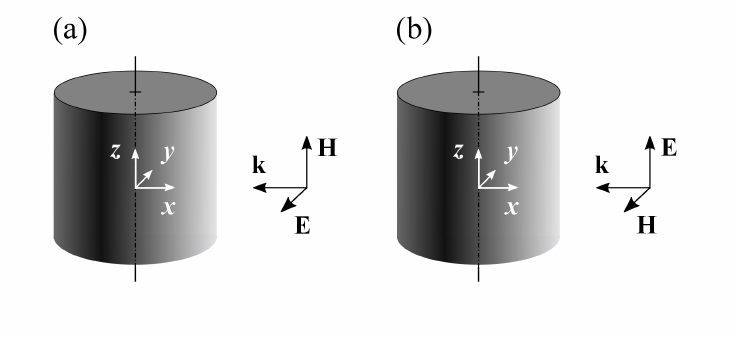
Figure 1. Mutual orientations of the cylinder and k , E , H vectors of the incident wave. TE polarization ( a ), TM polarization ( b